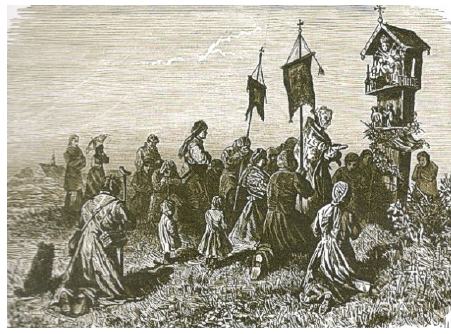
Figure 4. Procession in Samogitia [54].